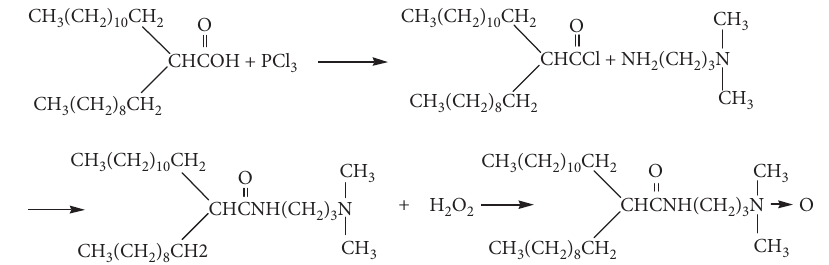
Scheme 1: Synthetic route of the